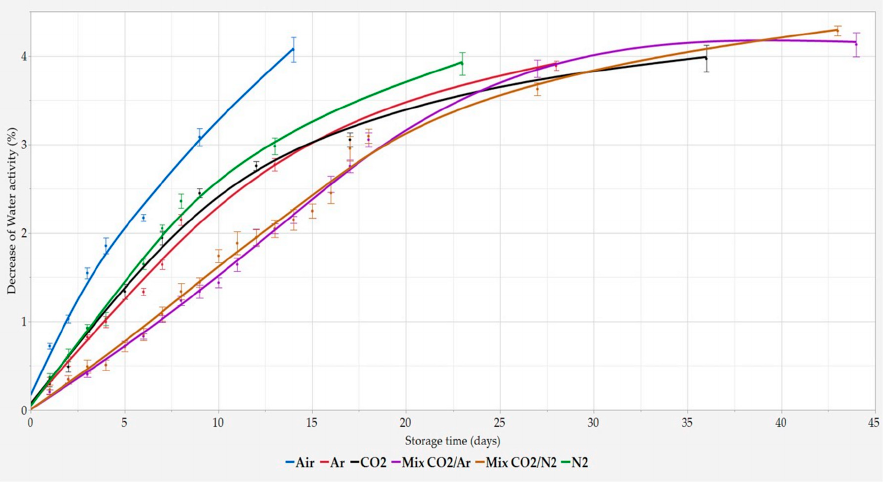
Figure 3. Percentage decrease in water activity during storage time. Results are expressed as mean ± SD (n = 4).